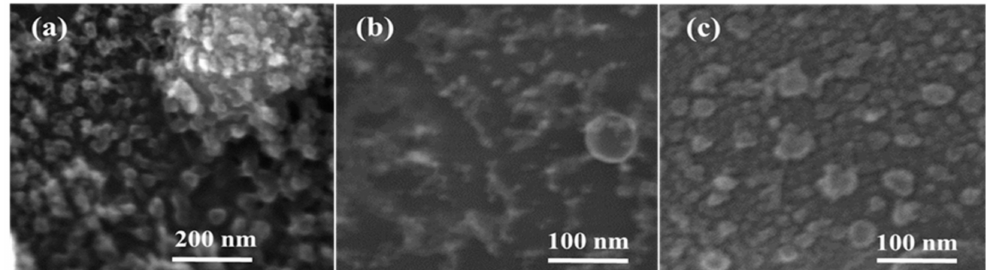
Figure 2. Top-view SEM images of laser-ablated samples obtained at di ff erent ratio R between partial pressures of helium and nitrogen: R = 0 ( a ); R = 0.1 ( b ); R = 1 ( c